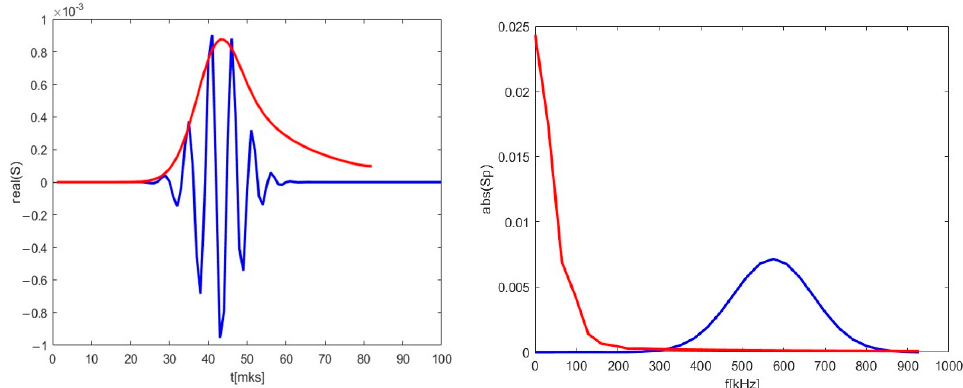
Figure 15. ( left ) DBS signals for the 48 GHz probing frequency; ( right ) calculated spectra of the signal on the left. The blue lines correspond to the reference signal from Figure 13. The red lines correspond to the calculations for trajectory in Figure 12.